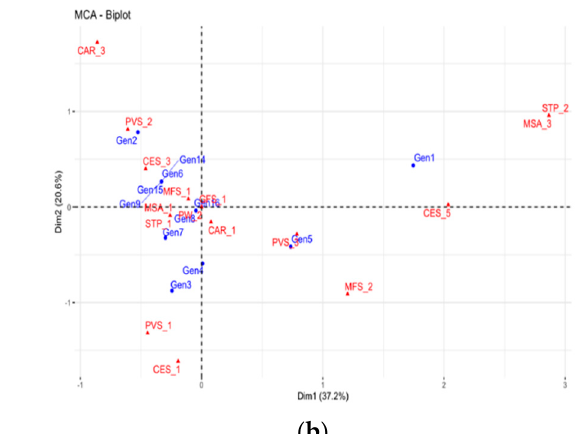
The multiple correspondence analysis performed for the qualitative descriptors in the open-field system showed that 67.8% of the total variance was explained by the first two components: CP1 (40.2%) and CP2 (27.6%). The first component grouped the genotypes according to characteristics such as the rough texture of the phylloclade surface (STP), the absence of pigmentation in the vegetative shoots (PVS), and light gray coloration in the areolas (CAR). The second component presented intense pigmentation in the vegetative shoots (PVS), in addition to having a compressed mature fruit shape (MFS) and a dark brown color of the spines (CES) (Figure 5a).